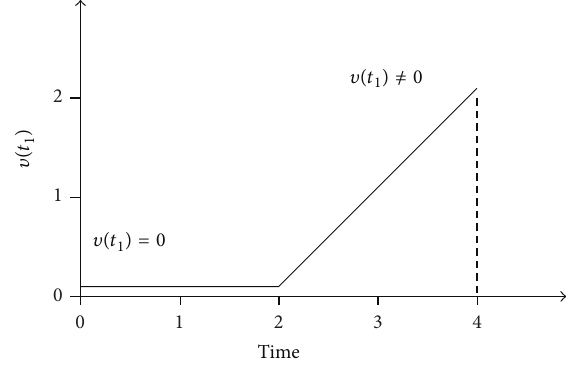
Figure 8: Clock evaluation of 𝑡 1 in the controlled TPN of Figure 9.